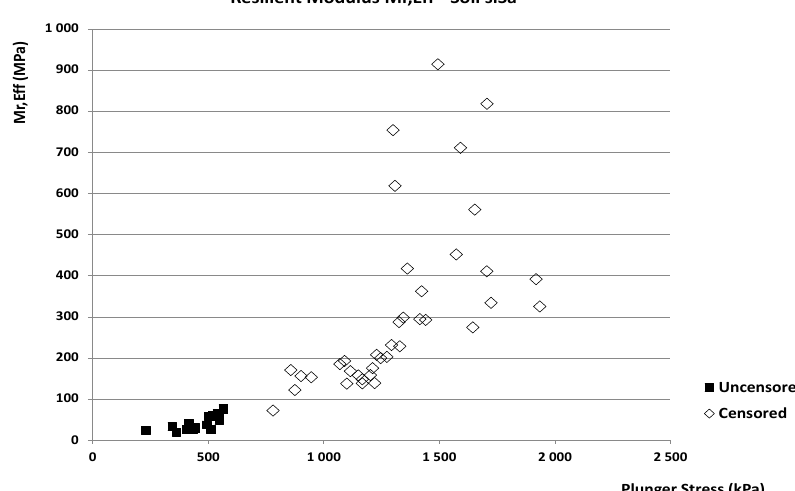
Figure 9. Resilient modulus M r,eff for soil siSa. Soil grsiSa